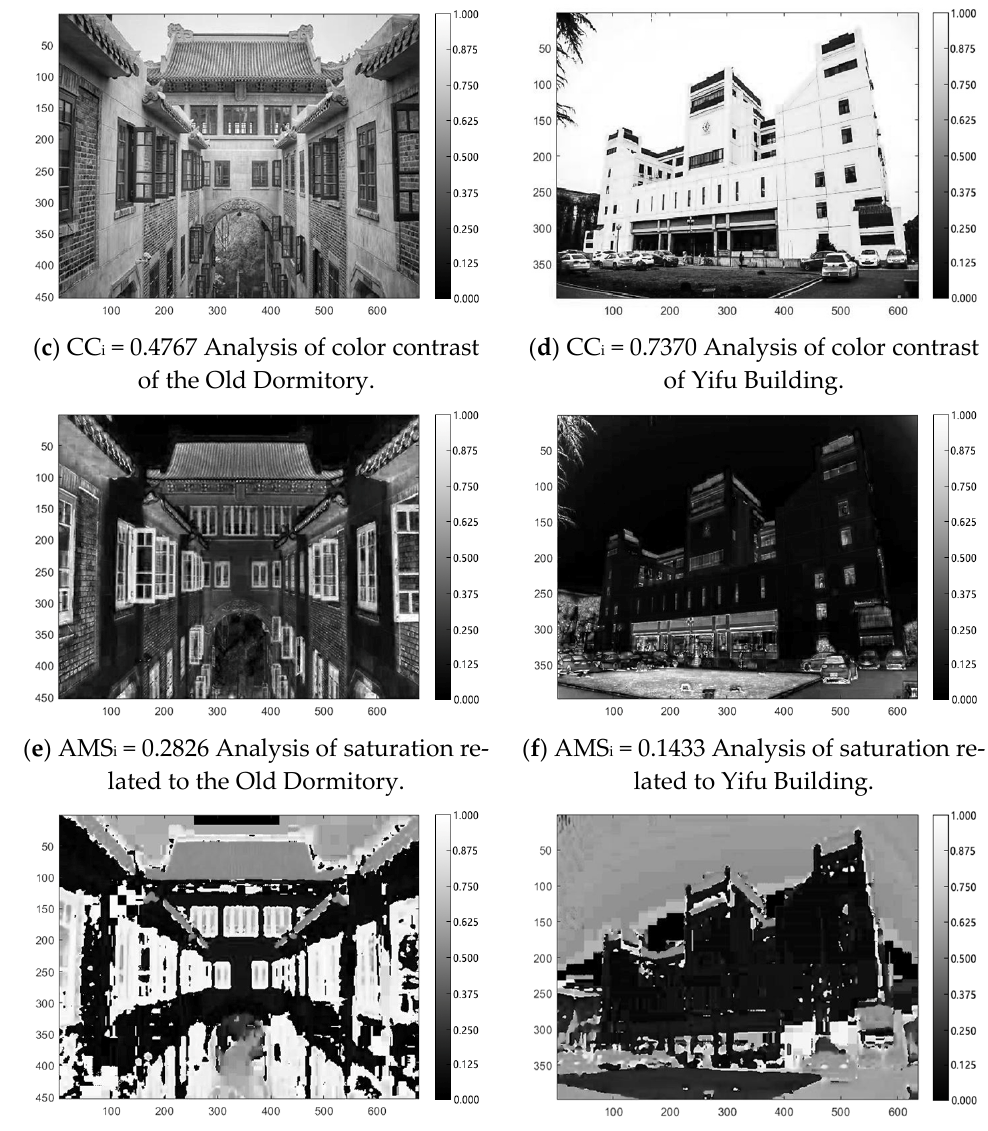
Figure 7. The analysis of the color of two typical photographs shared on Weibo based on MATLAB.